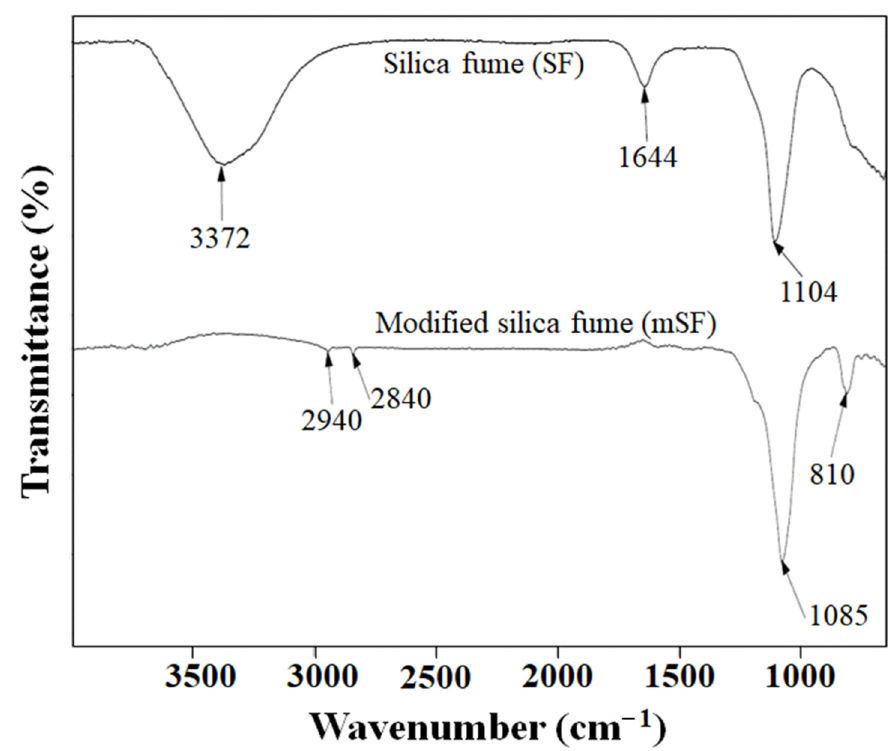
Figure 1. FTIR spectra of silica fume (SF) and modified silica fume (mSF).